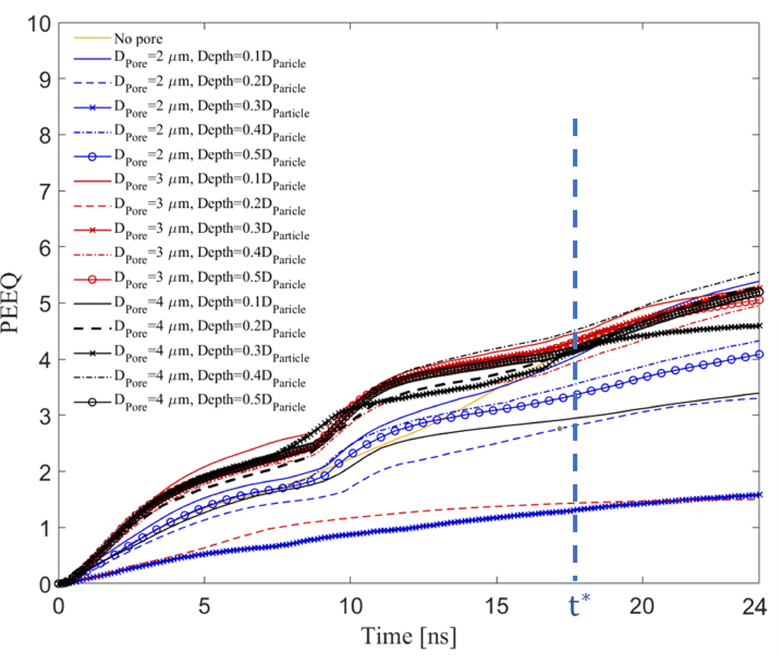
Figure 7. The equivalent plastic strain (PEEQ) over the contact-surface of the Al substrate and B 4 C particle for D Particle = 15 µ m and V Impact = 500 m/s with a pore with diameters: D Pore = 2, 3, and 4 µ m, placed at different depths from the surfaces (0.1 D Particle , 0.2 D Particle , 0.3 D Particle , 0.4 D Particle , and 0.5 D Particle ). t* in the figure defines a time for comparative purposes across all tests after which the PEEQ increases linearly at more-or-less the same rate across all